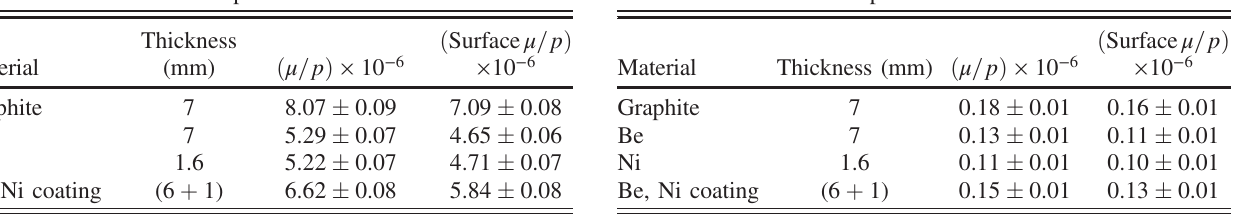
TABLE II. Total and surface muon yield detected by the ISIS